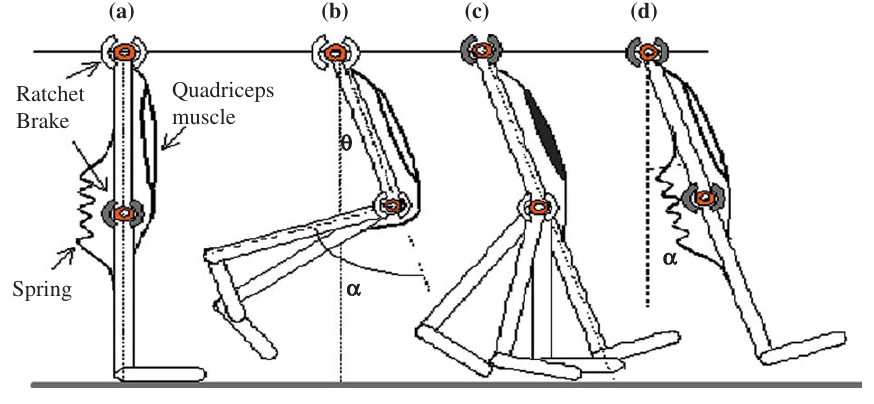
Fig. 4. SBO swing phase synthesis.